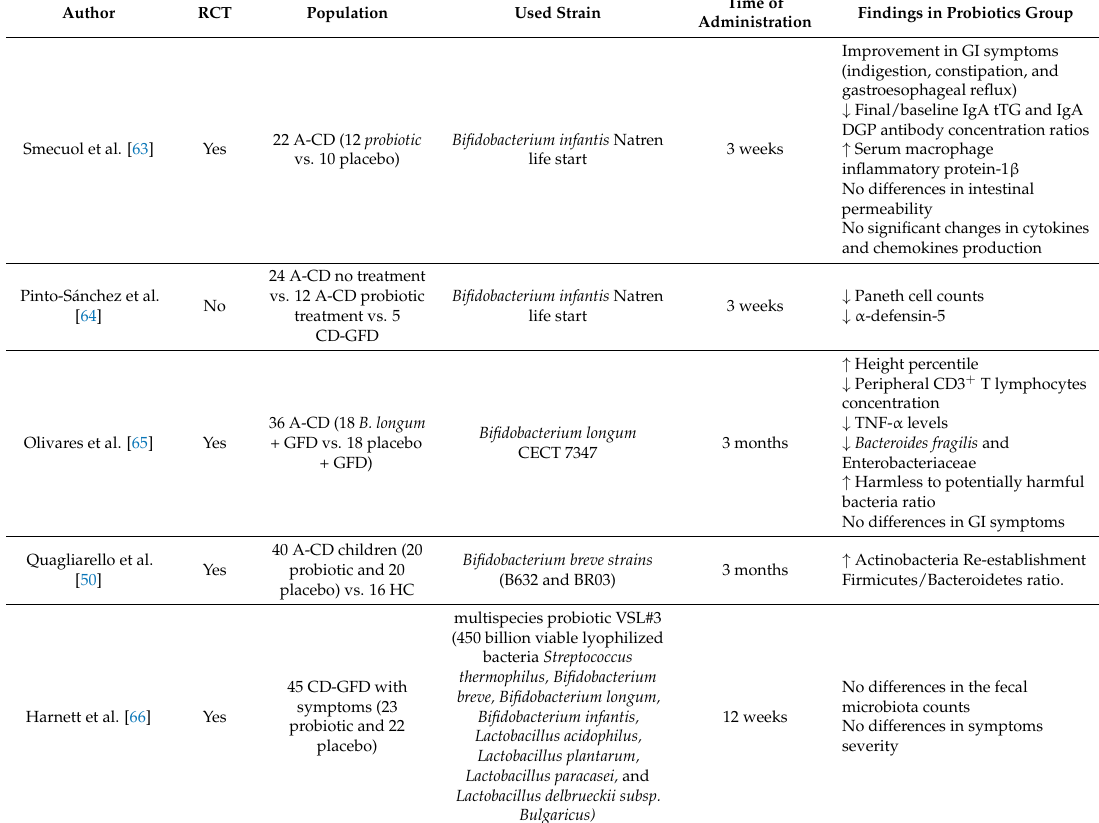
Table 2. Main evidence on the use of probiotics in patients with celiac